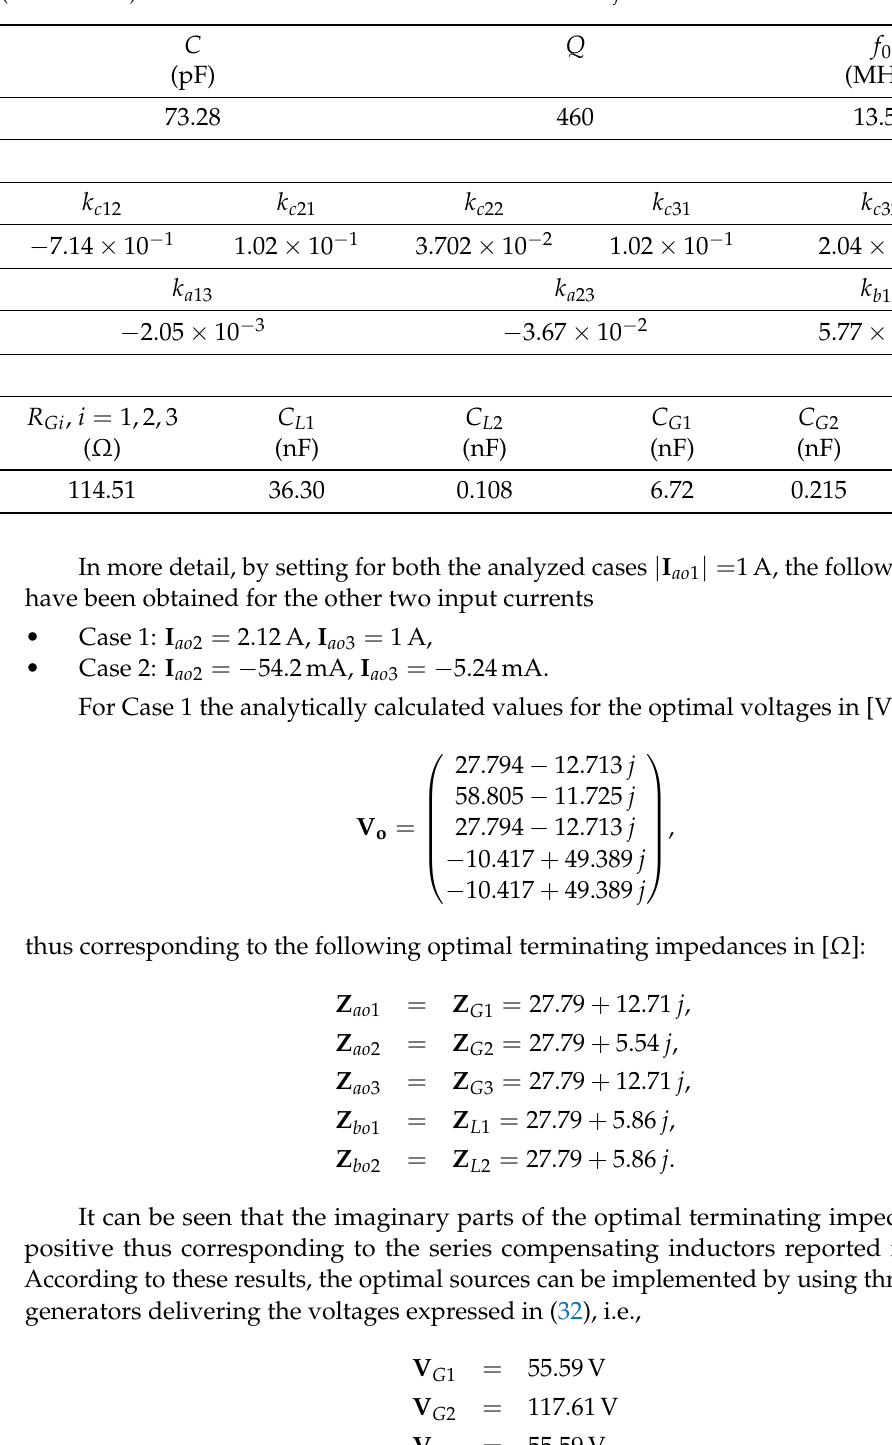
Table 2. Parameters of the equivalent circuit and optimal loads for Case 2. C L , i and C G , j (or L L , i and L G , j ) are the optimal compensating capacitors (or inductors) to be used for the receiver i and the transmitter j